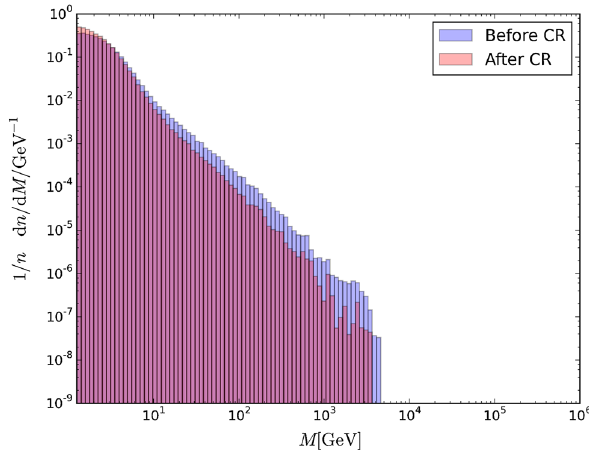
Fig. 1 Distribution of invariant cluster masses before and after colour reconnection for a pp collision with centre-of-mass energy of